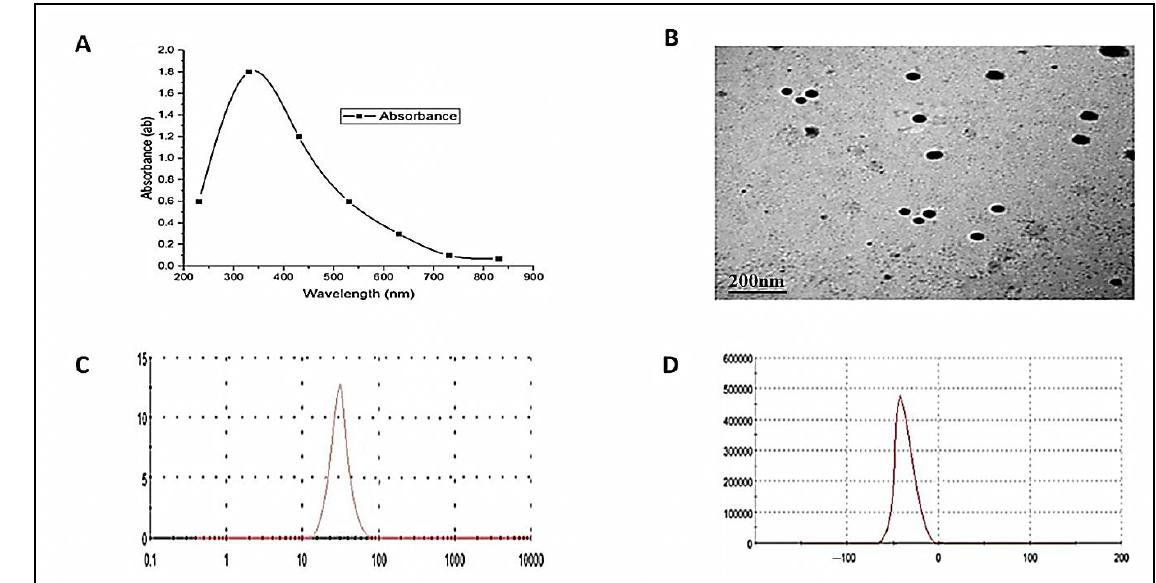
Figure 1. Characterization of ZnO-NPs by four devices: UV – VIS spectroscopy analysis showed the maximum peak at 340 nm ( A ); the ZnO-NPs were spherical with an average size of 108 nm ( B ); the size was estimated based on the Brownian motion of the ZnO-NPs in suspension, where the exact size was 89 nm ( C ); the zeta potential analysis was carried out to determine the surface charge of ZnO-NPs, which ensures the stability of synthesized nanoparticles, where the net surface charge was − 33 mV ( D ).